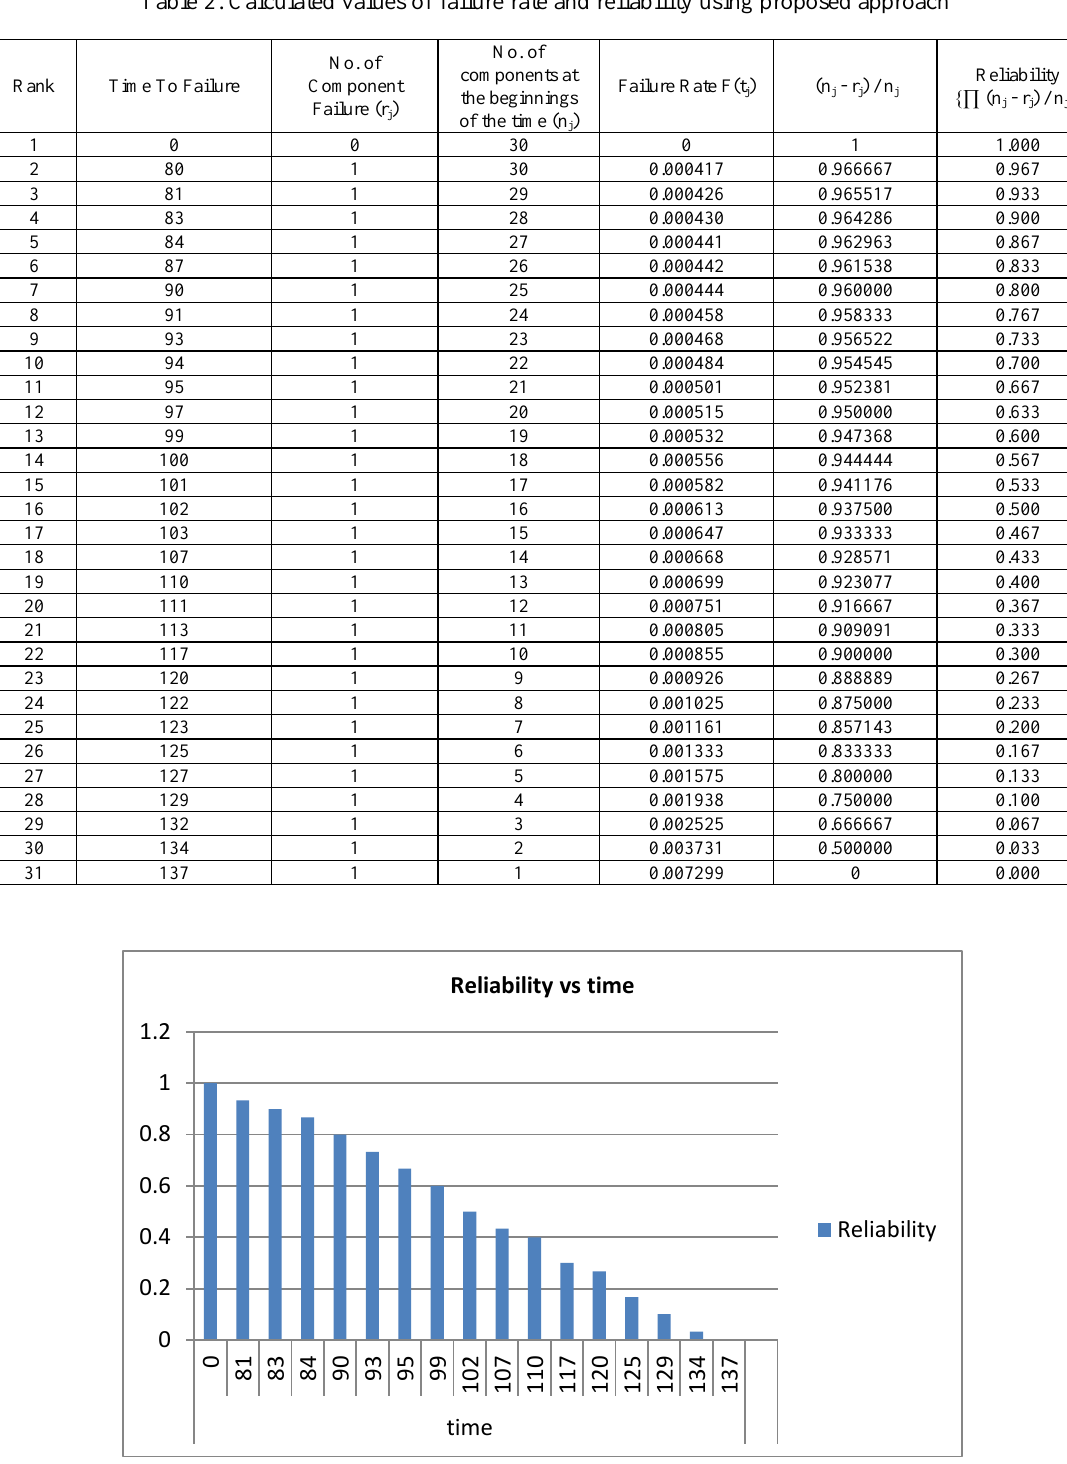
Figure 3. Reliability vs. time